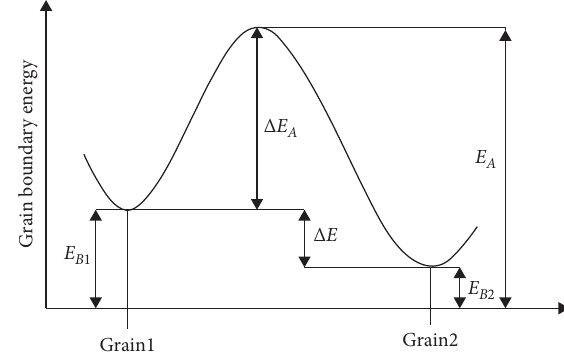
Figure 1: The energy transformation of the atom during the transition